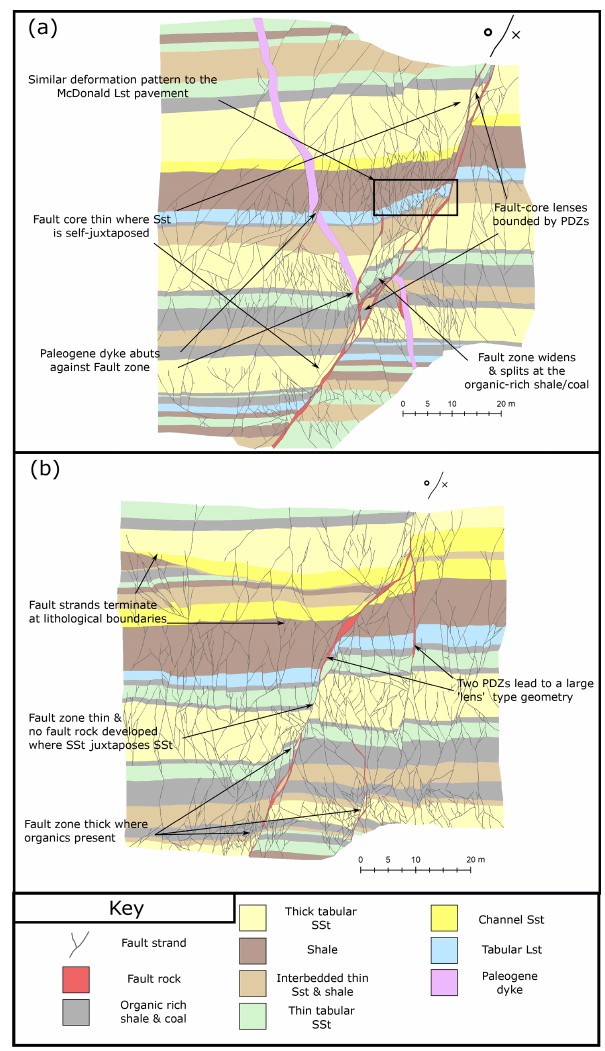
Figure 7. Digitised fault strands of sinistral faults cutting the Lime- stone Coal Formation exposed along the high wall. (a) Sinistral fault that displays between 2 and 5m of apparent (vertical) throw. A later Paleogene dyke, associated with the British Tertiary Igneous Province, intrudes across the fault; however, no evidence of white trap or dyke material is observed in the fault core (see Table 4 for discussion). (b) Sinistral fault that displays between 2 and 8m apparent (vertical) throw along two principle displacement zones (PDZs). SSt stands for sandstone, and LSt stands for limestone. Photomontage provided courtesy of the British Geological Survey